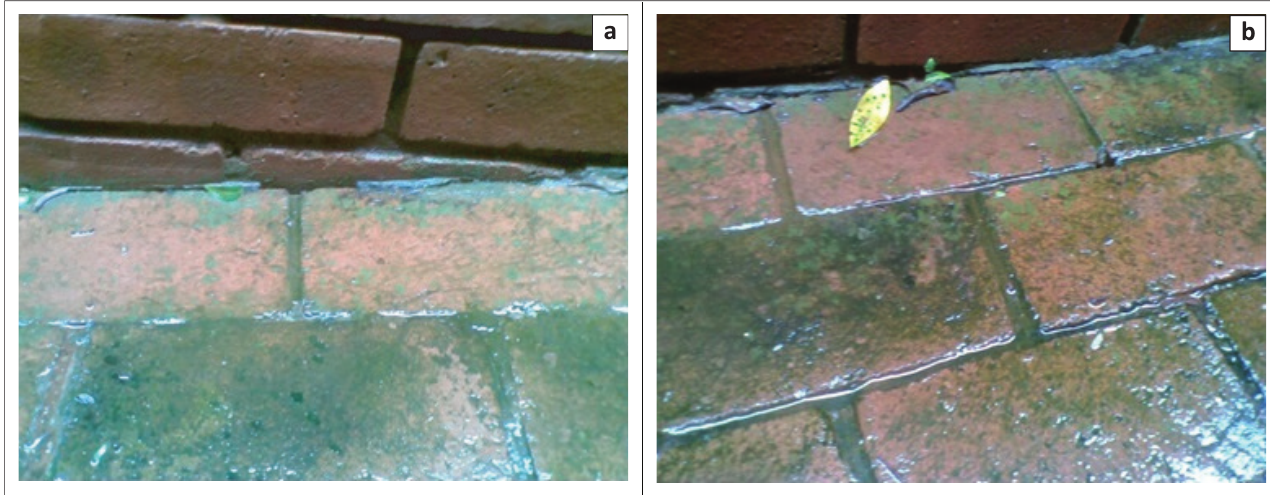
FIGURE 3: (a & b) The presence of algae on the pavement bricks during a rain